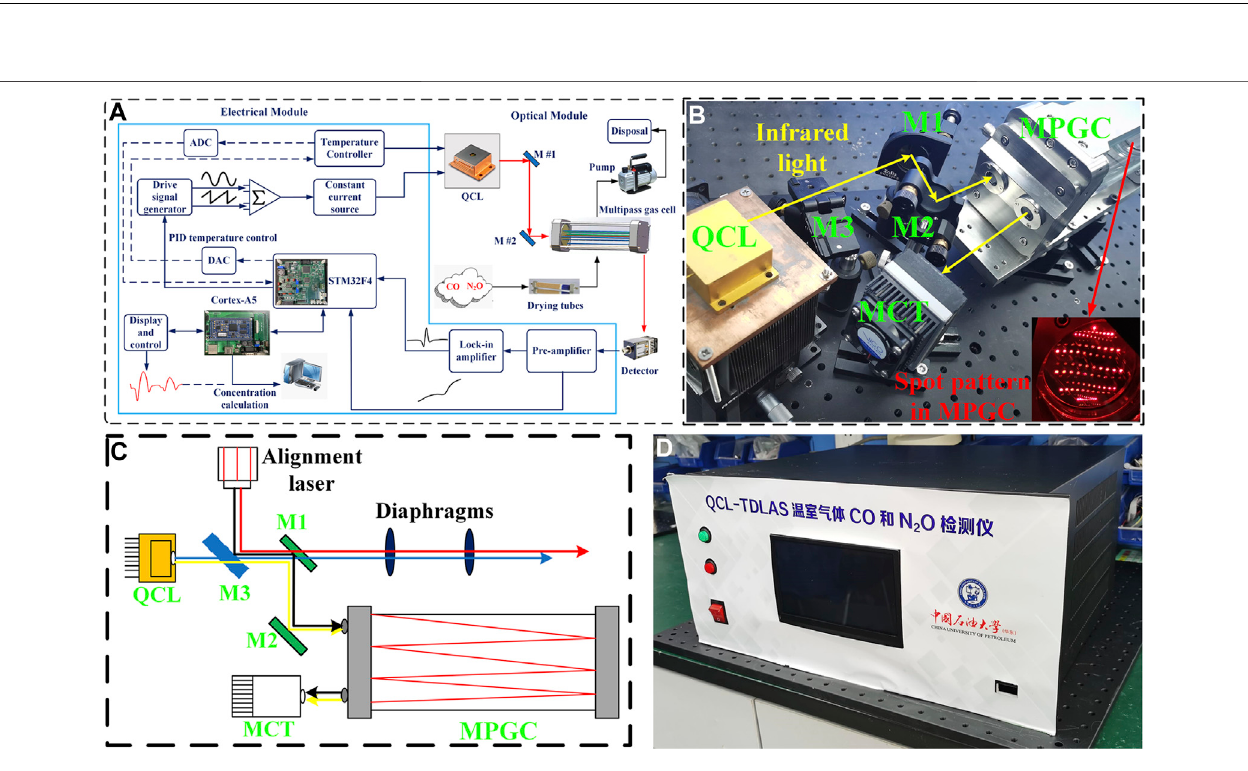
Frontiers in Chemistry |